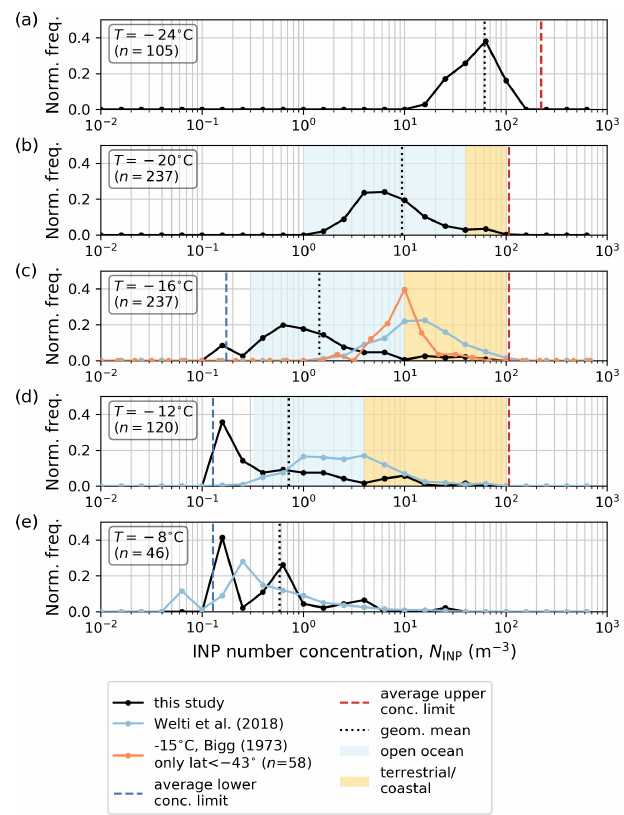
Figure 8. Normalized probability density functions (solid black line) and geometric mean values (dotted black line) for INP number concentrations ( N INP ) at (a) − 24, (b) − 20, (c) − 16, (d) − 12, and (e) − 8 ◦ C from the LV filters sampled during ACE. For reference, N INP , − 16 , N INP , − 12 , and N INP , − 8 for Cabo Verde (North Atlantic; Welti et al., 2018) are given in (c)–(e) , respectively (blue). Addi- tionally, N INP , − 15 from Bigg (1973) for data points south of 43 ◦ S (orange) is given for comparison. A classification of modes based on sampling location and air-mass origin is given (yellow area: ter- restrial/coastal; light blue area: open ocean). Averages of the upper (dark red) and lower concentration limit (dark blue) are indicated by dashed lines. The number of data points ( n ) are indicated in the